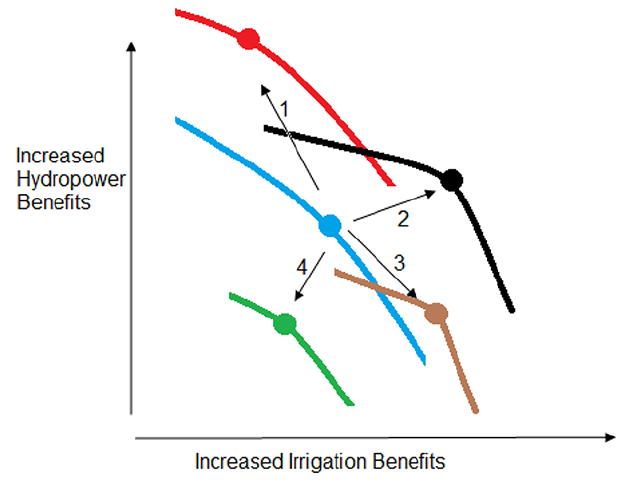
Figure 6. Schematic of the four possible ways in which changing conditions can shift the optimum model solution from a baseline set of solutions represented by the blue curve. Arrow 1 (shift to the red curve) depicts a win–loss tradeoff where a loss in irrigation benefits is offset by an increase in hydropower benefits. Arrow 2 (shift to the black curve) depicts a win–win outcome, with a gain in both hydropower and irrigation. Similarly, arrows 3 and 4 can be characterized as loss–win and loss–loss,